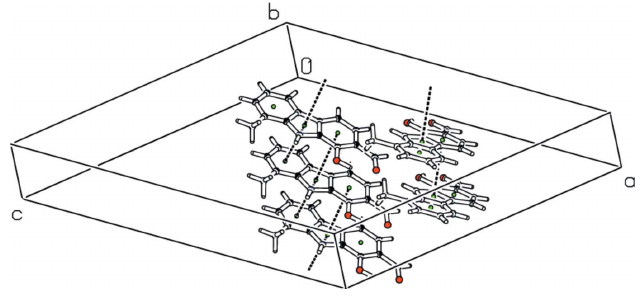
Figure 4 Straw-style packing view of the title compound, viewed down the b axis, showing slipped (cid:2) – (cid:2) stacking interactions. Centroids are indicated by green spheres and contacts between centroids by black dotted lines.